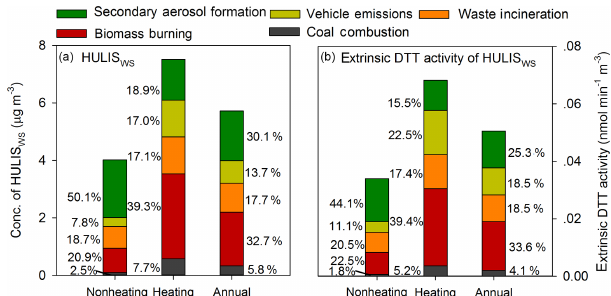
Figure 4. Source-specific contributions to HULIS WS mass concen- tration (a) and extrinsic DTT activity of HULIS WS (b)